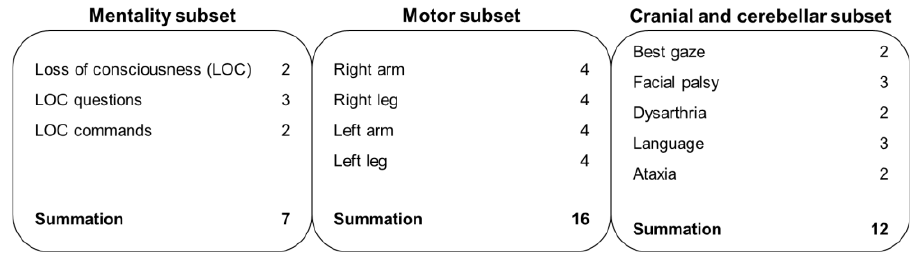
Figure 2. Prodrome was defined as a preceding fluctuation of neurological symptoms suggestive of a vertebrobasilar transient ischemic attack. J. Clin. Med. 2020 , 9 , x FOR PEER REVIEW